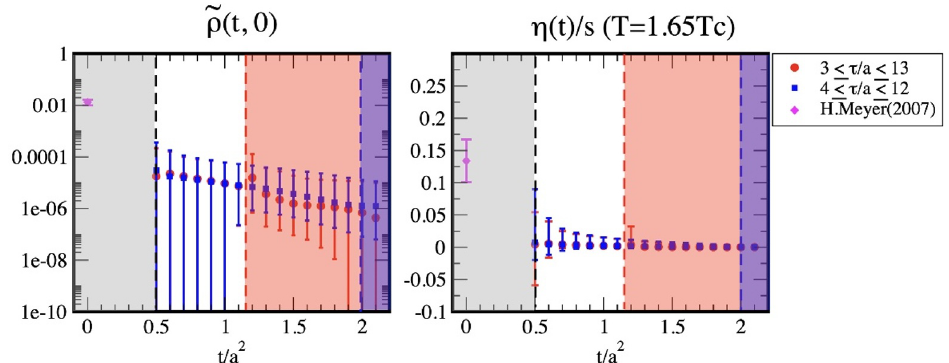
Figure 14 . (Left) The spectral function at ! = 0. (Right) The ratio between the shear viscosity and the thermal entropy ( (cid:17)=s ). Horizontal axes denote the (cid:13)ow-time. Magenta data at t=a 2 = 0 denotes the result by H. Meyer at the same temperature [14]. The (cid:12)ducial window (2 a < is indicated by the dashed lines, where the meaning of each line and shadowing region is the same with the one in (cid:12)gure